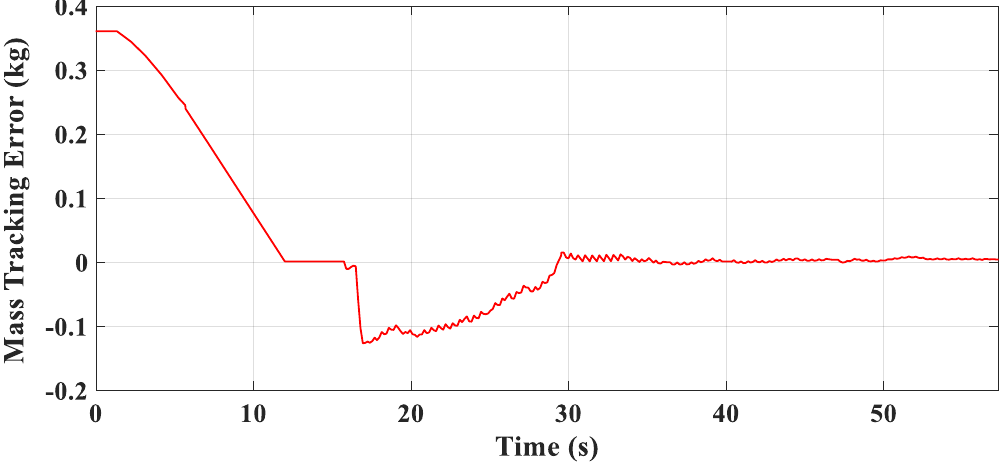
Figure 16. Demanded and actual ballast mass changes of depth control via on-off type VBS.